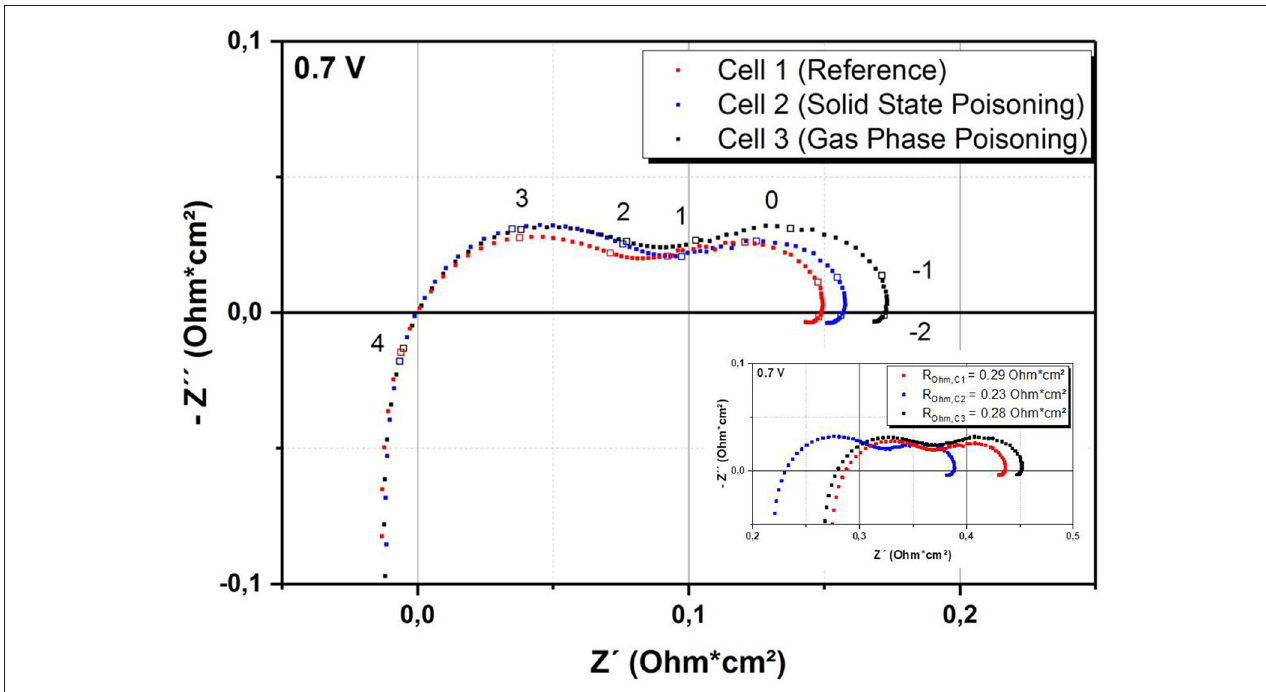
FIGURE 3 | Comparison of impedance data of the cells taken at 0.7V and 700 ◦ C. Frequencies (in Hz) used for impedance spectroscopy are given on a logarithmic scale. Inset: Original data without subtraction of the ohmic